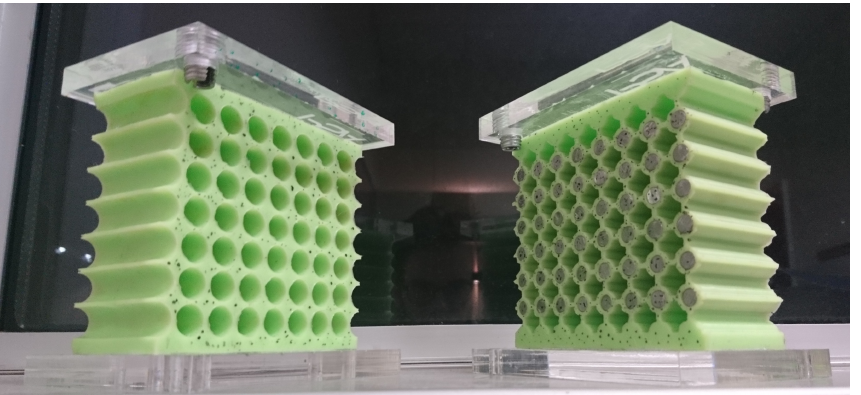
Figure 6. Samples S 0 ( left ) and S R ( right ) used in this